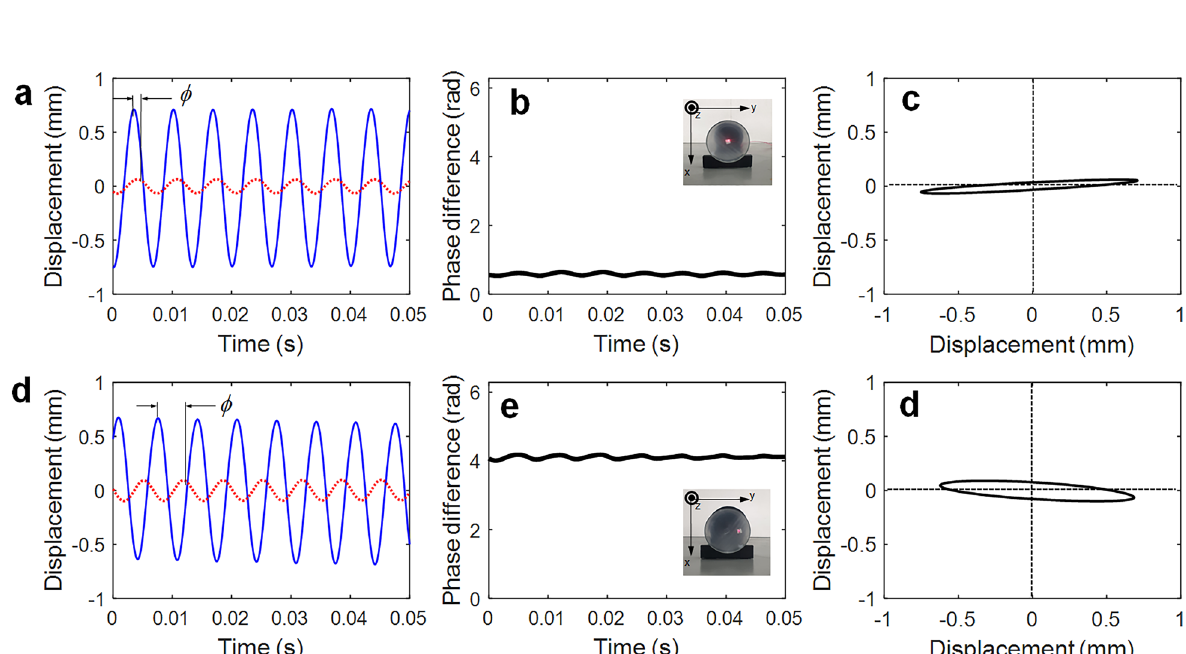
Figure 4. Phase angle difference between the transverse and longitudinal vibrations in the diaphragm at the frequency of 150 Hz: ( a,d ) measured two vibration responses blue line z -direction, red dotted line y -direction, ( b,e ) phase difference θ = 0.59 rad (33.8°) for ( a ) and θ = 4.11 rad (235.5°) for ( d ), ( c,f ) its Lissajous curve, ( a–c ) at the center of the diaphragm, ( d–f ) at the off-center of the